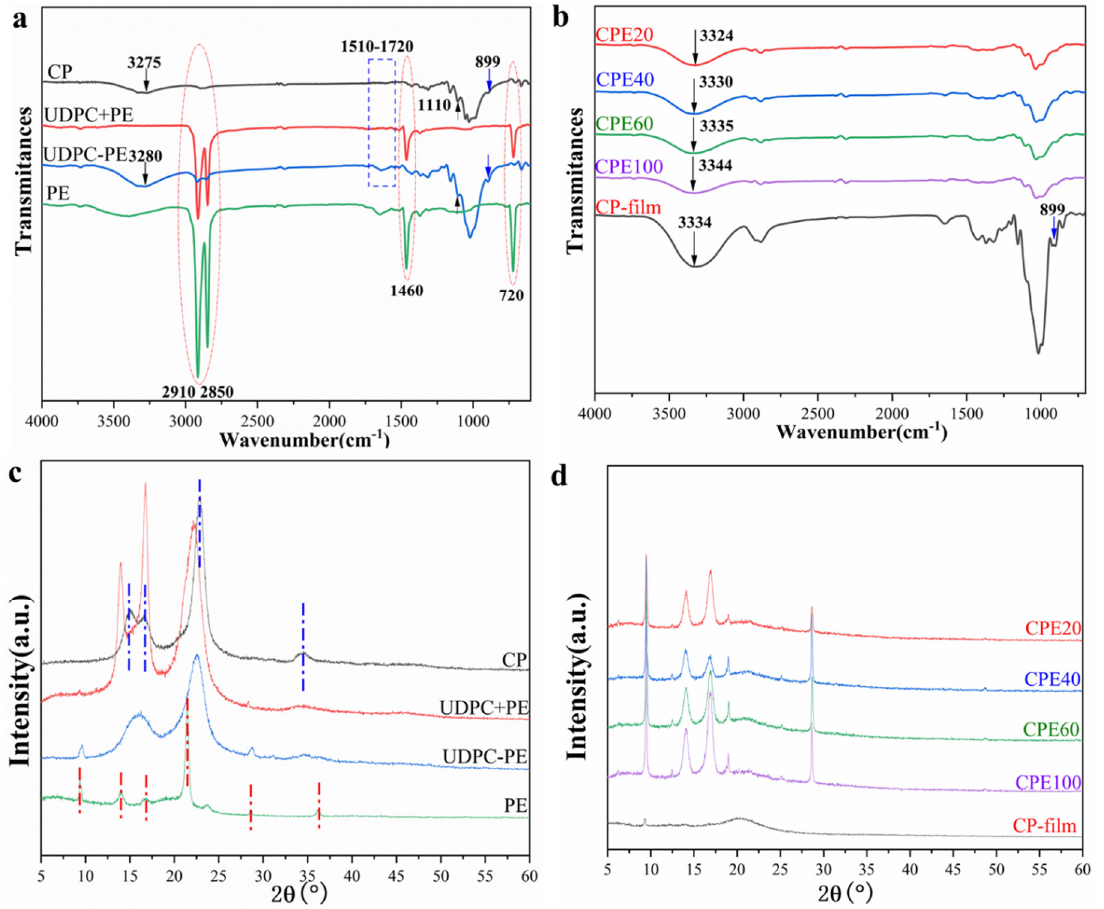
Figure 4. ( a ) XRD of CP, UDPC+PE, UDPC-PE and commercial PE film; ( b ) XRD of CP-film and the cellulose/polyethylene composite films; ( c ) FTIR of CP, UDPC+PE, UDPC-PE and commercial PE film; ( d ) FTIR of CP-film and the cellulose/polyethylene composite films.